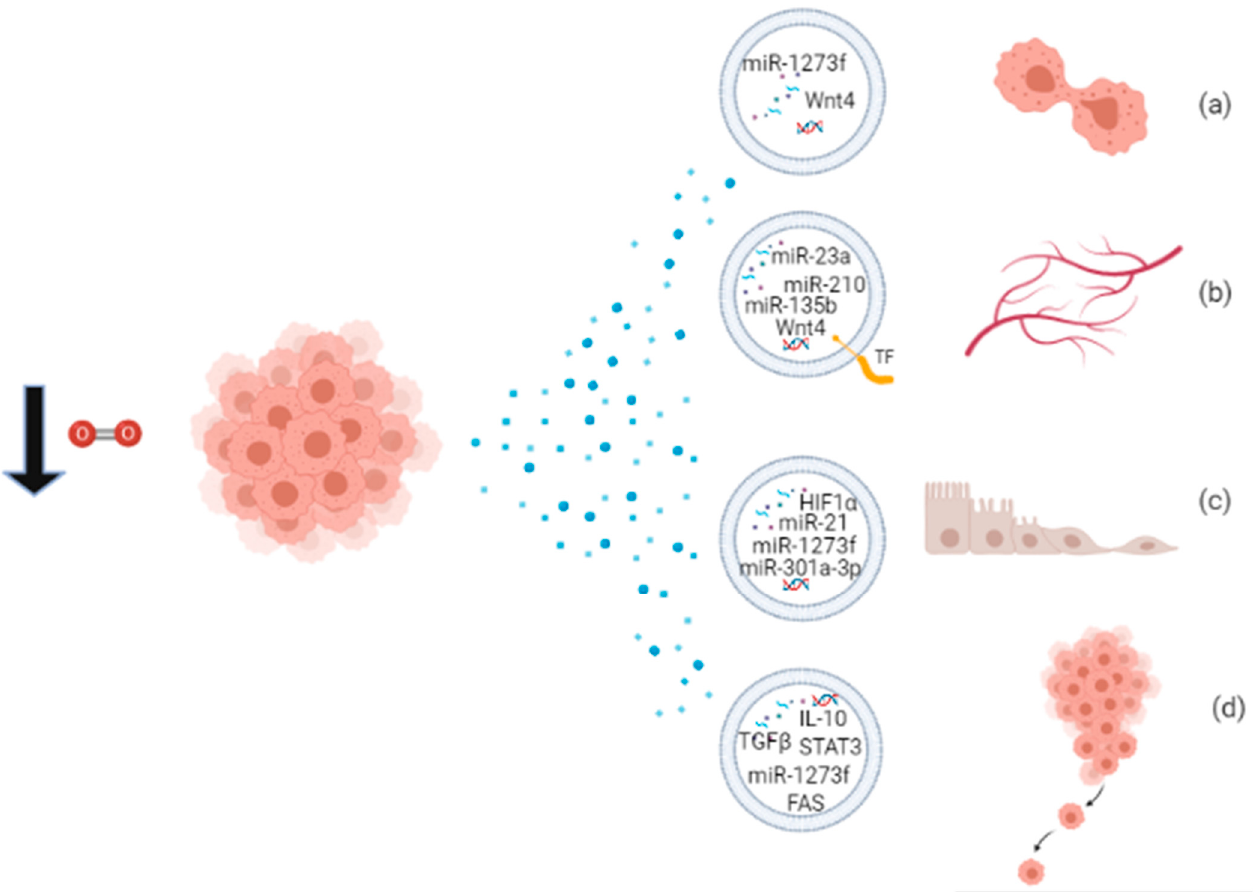
Figure 2. Proliferating cancer cells in hypoxic condition release EVs packaged with biomolecules involved in ( a ) proliferation; ( b ) angiogenesis; ( c ) EMT; and ( d ) metastatic behavior.